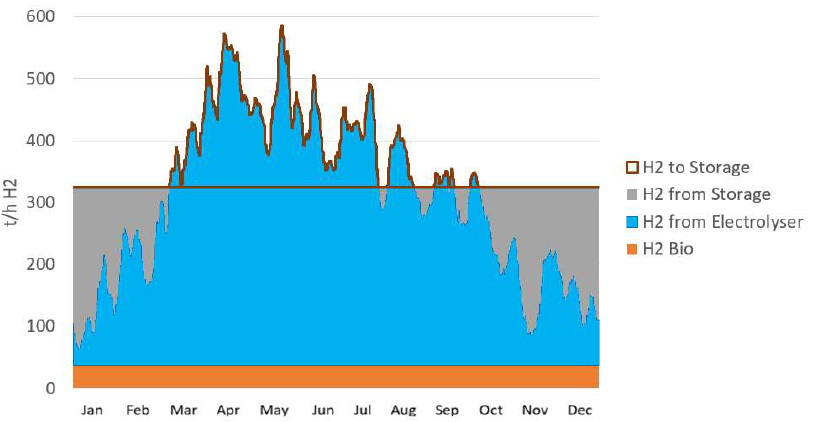
Figure 14. Weekly moving average of H2 production with flat generation of H2 from biomass gasification.